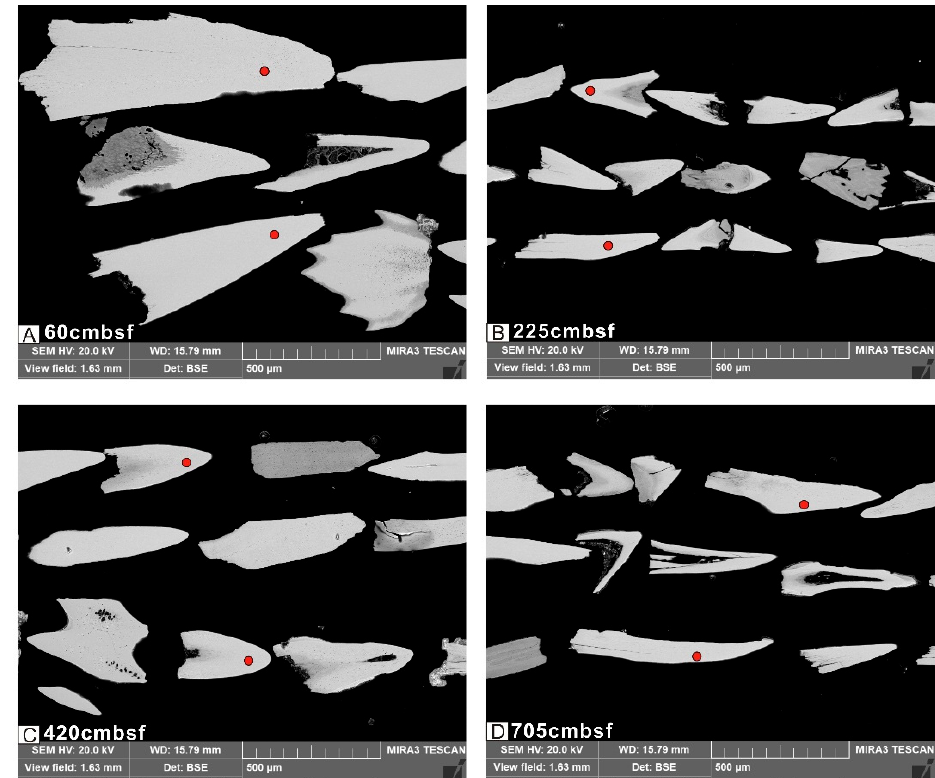
Figure 3. Representative BSE images of fish teeth debris grains from the core P10. Red circles show the location of LA-ICP-MS Sr analyses. ( A – D ) samples from different depths of the P10.